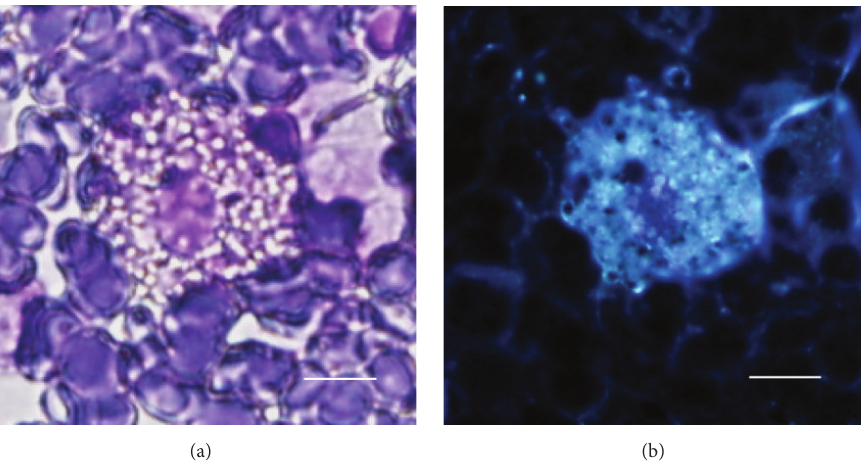
Figure 1: (a) High power view of the May-Giemsa-stained bone marrow aspirate. A large macrophage laden with sphingomyelin gives the cytoplasm a foamy appearance. (b) Positive filipin staining of a foam cell is observed on the same field as (a) (scale bar: 10 𝜇